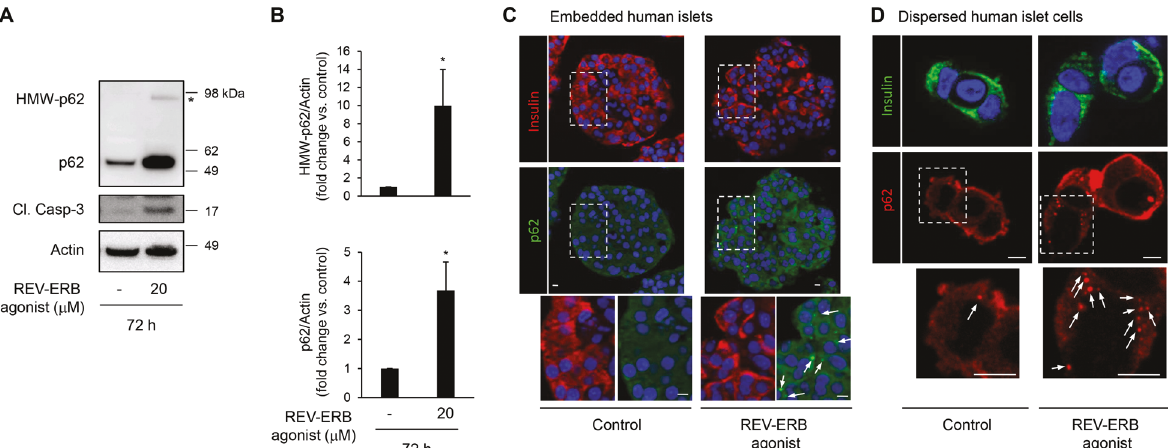
Fig. 4 REV-ERB α agonism impairs autophagic fl ux in human islets. A Human islets were exposed to REV-ERB agonist (SR9009, 20 μ M, 72 h) or control (DMSO). Protein levels of p62, high molecular weight (HMW)-p62, Cleaved Caspase-3, and actin (loading control) were analyzed by western blot. B Graphs represent the quanti fi cation of the blots ( n = 4 independent experiments). Data are expressed as mean ± SEM; * P < 0.05 vs. control. C p62 staining was assessed by immuno fl uorescence (p62, green; insulin, red; nuclei, blue) in paraf fi n-embedded human islets exposed to REV-ERB agonist (SR9009, 20 μ M, 72 h) or control (DMSO). D Dispersed human islets cells were exposed to REV-ERB agonist (SR9009, 20 μ M, 24 h) or control (DMSO), and then fi xed for immuno fl uorescence detection of p62 (red), insulin (green) and nuclei (blue). p62- positive cytoplasmic inclusions in β -cells are indicated with arrowheads. Scale bar: 5 μ